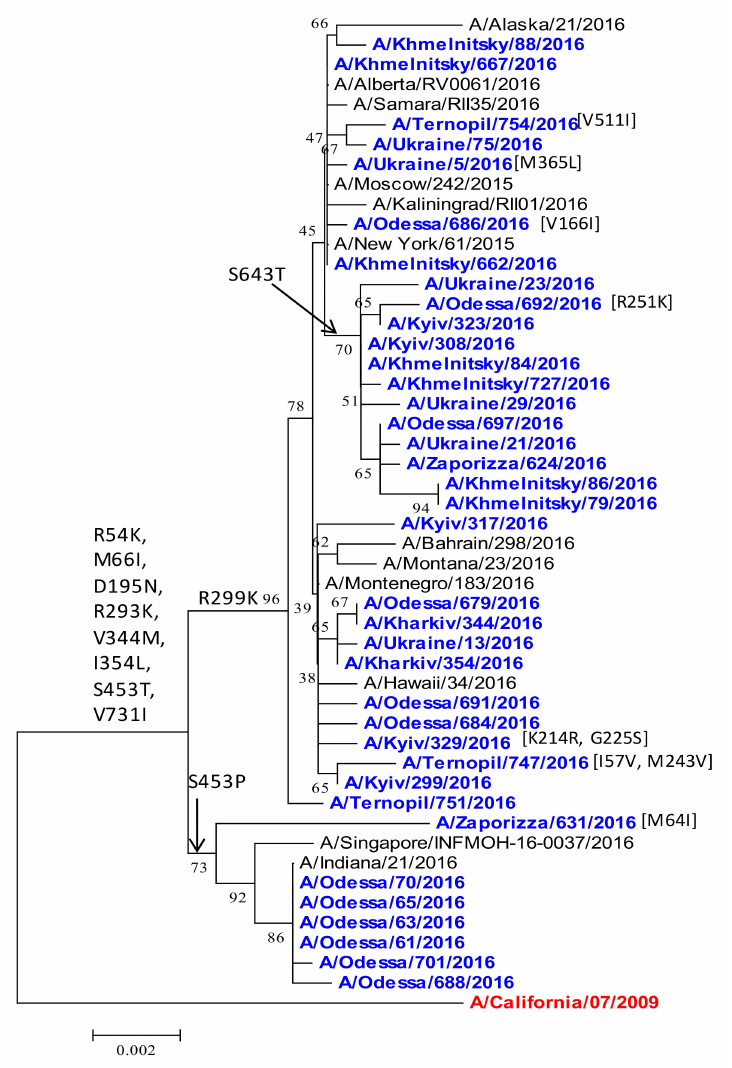
Figure 11. Phylogenetic comparison of A(H1N1)pdm09 influenza virus PB2 from the 2015/16 season. PB2 nucleotide sequences were analyzed by NJ method, Kimura 2-parameter model, with 1000 bootstrap replications. The Ukrainian 2015/16 isolates (blue), reference strains (black), and the vaccine strain